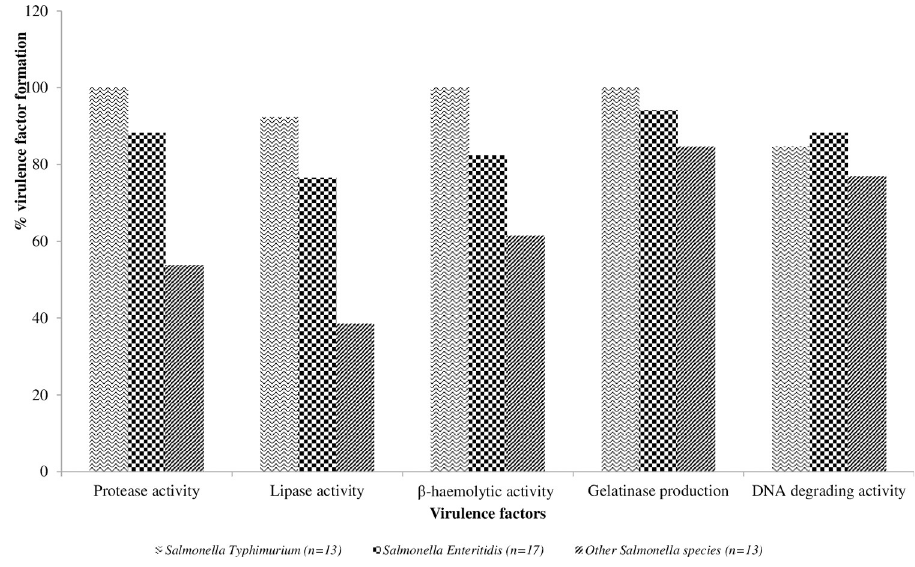
Fig 3. Distribution of phenotypic virulence factors of the Salmonella serovars.